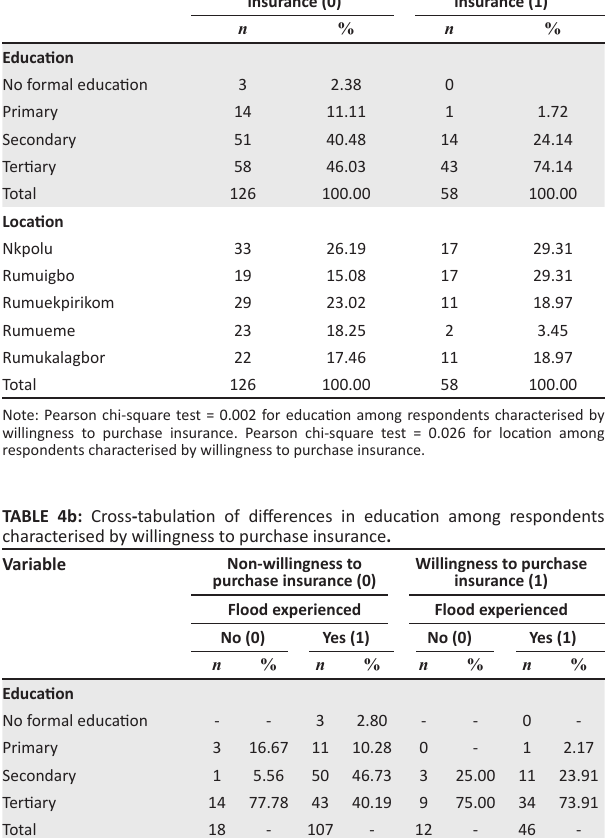
TABLE 4a: Cross-tabulation of differences in education and location among respondents characterised by willingness to purchase insurance. Variable